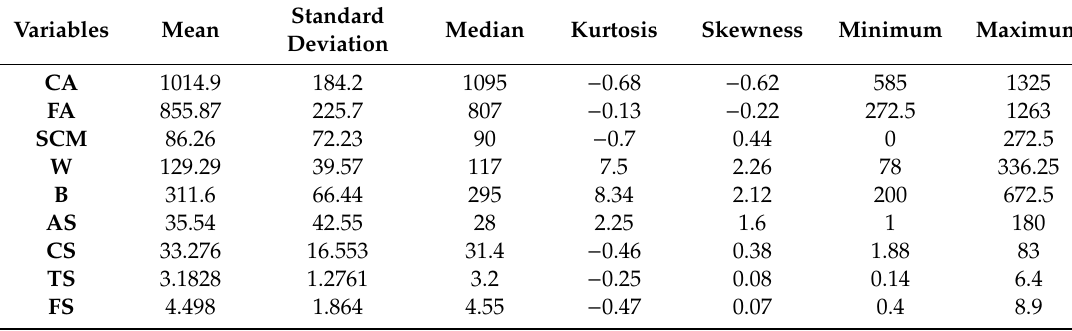
Table 2. Statistical measures of independent and dependent variables for compressive strength (CS), tensile strength (TS), and flexural strength